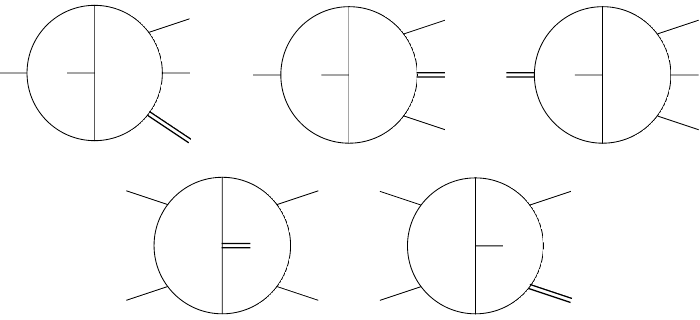
Figure 1 . The five non-planar families with one external massive leg. The first row corresponds to the so-called hexabox topologies, whereas the diagrams of the second row are known as double- pentagons. We label them as follows: N 1 (top left), N 2 (top middle), N 3 (top right), N 4 (bottom left), N 5 (bottom right). All diagrams have been drawn using Jaxodraw